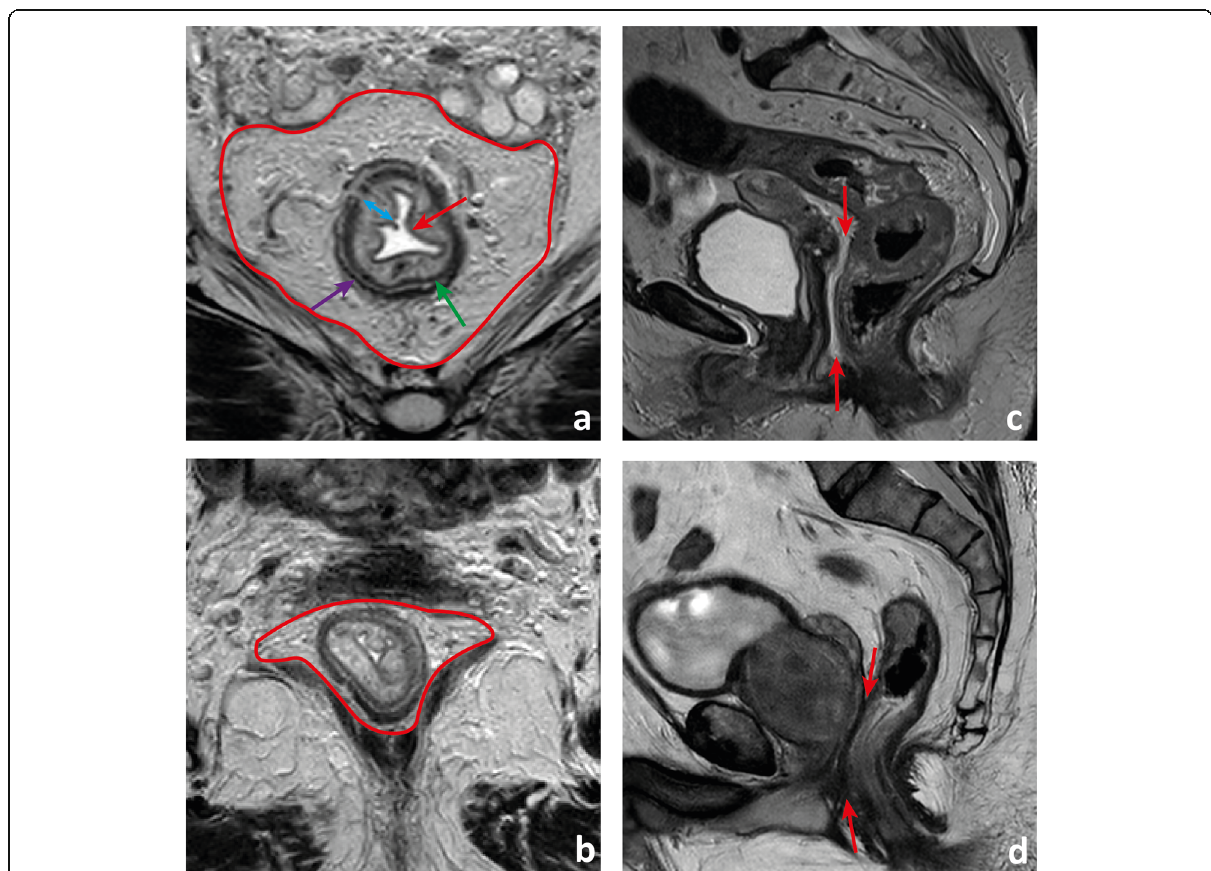
Fig. 3 The rectal wall. The mucosa is visible on T2-weighted imaging as a regular thin ( ≈ 1 mm) hypointense line delimiting the lumen (red arrow in a ). The submucosa is hyperintense and of variable thickness (double-headed blue arrow in a ). It may not be visible when the rectum is distended. The muscularis propria is composed of an inner circular layer (green arrow in a ) and an outer longitudinal layer (purple arrow in a ) which may be separated by a thin layer of fat, as in the example shown. Lying externally to it is a cushion of mesorectal fat (delimited in red in a ) that tappers inferiorly (delimited in red in c ) and anteriorly, where it can be thin (between arrows in c ) or even invisible (between arrows in d ), in which case the mid/low rectum appears juxtaposed to the Dennonvillier fascia